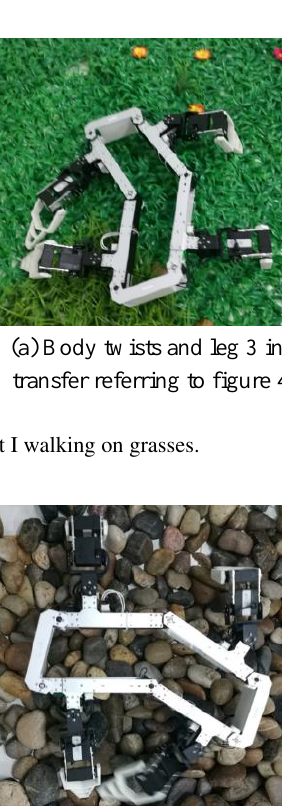
Figure 18. The MetaRobot I walking on the level terrain.